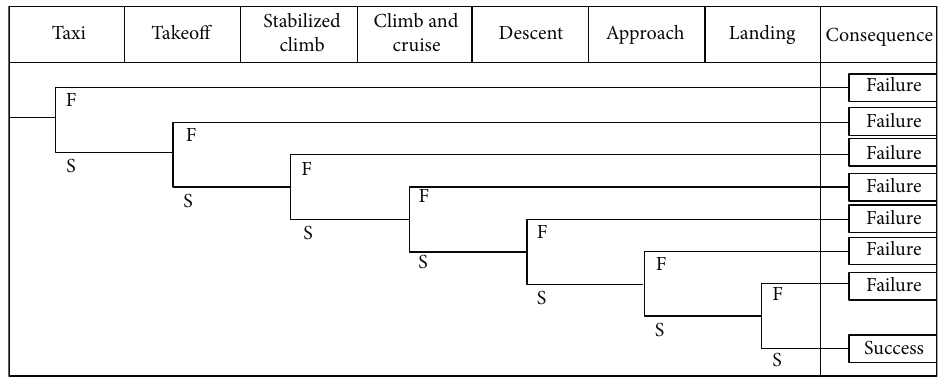
Figure 2: Flight task event tree.